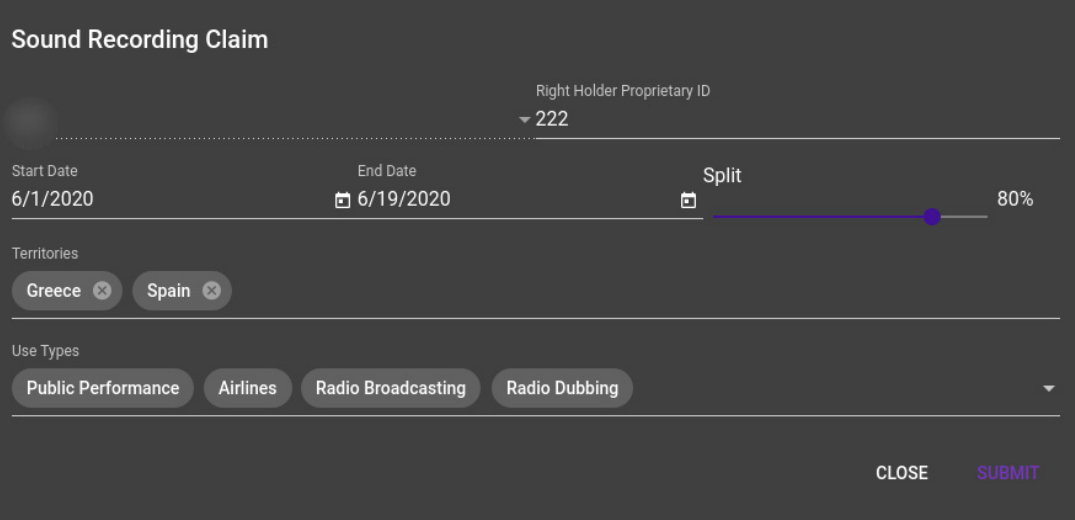
Figure 8. Claim overview with claim data when updating a claim.